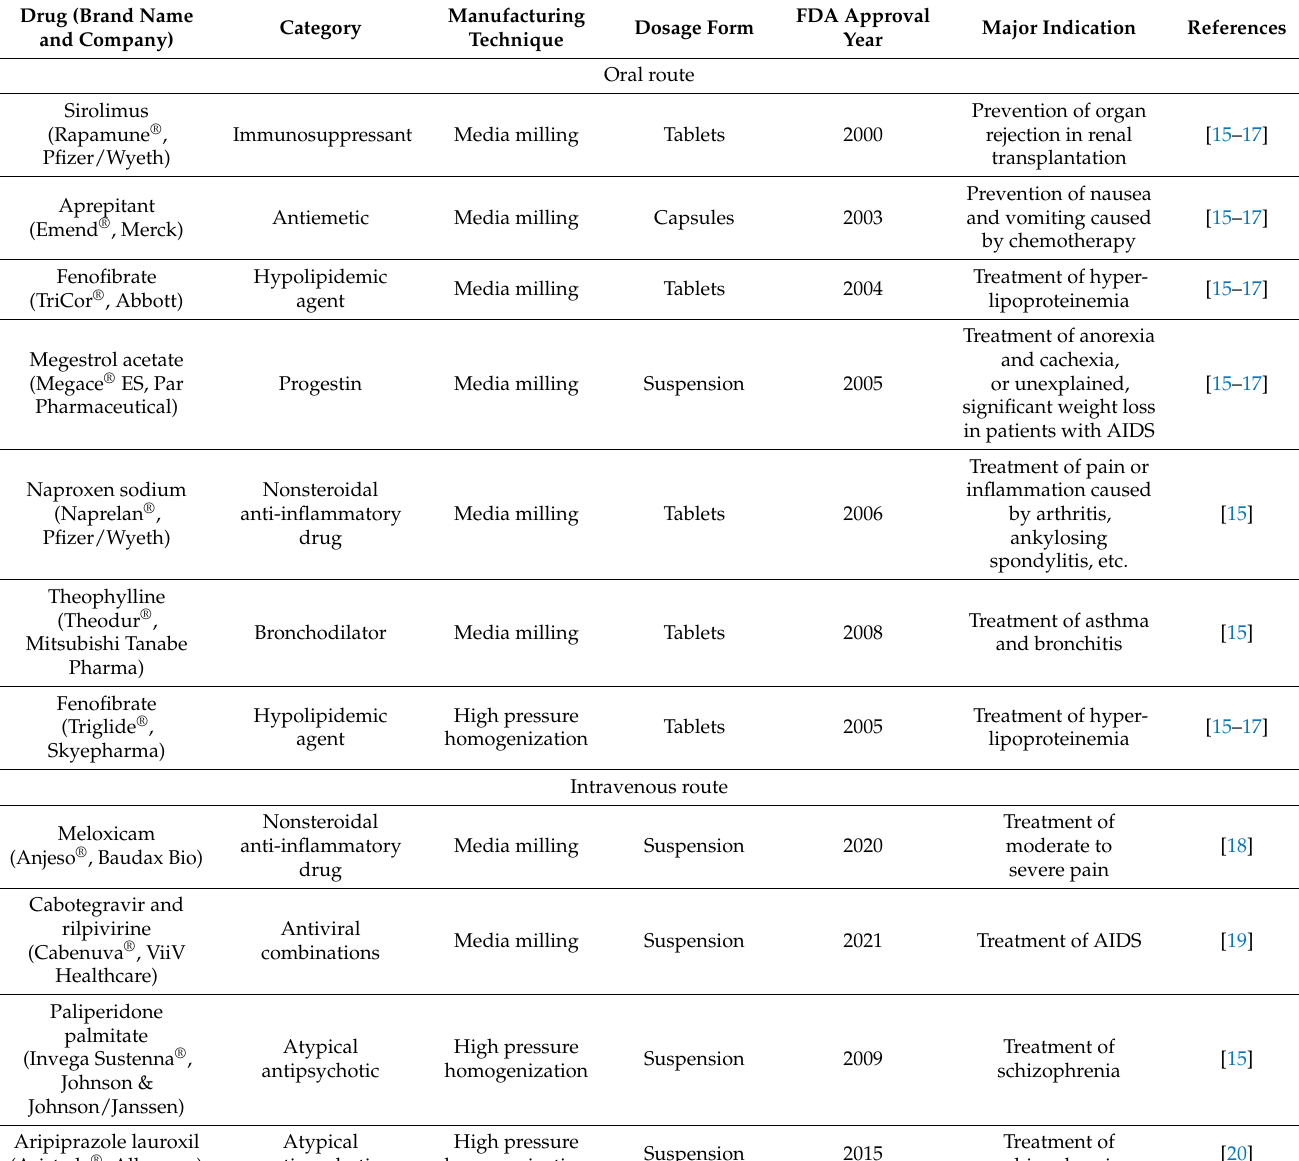
Table 1. Typical marketed drug NCs products manufactured by top-down